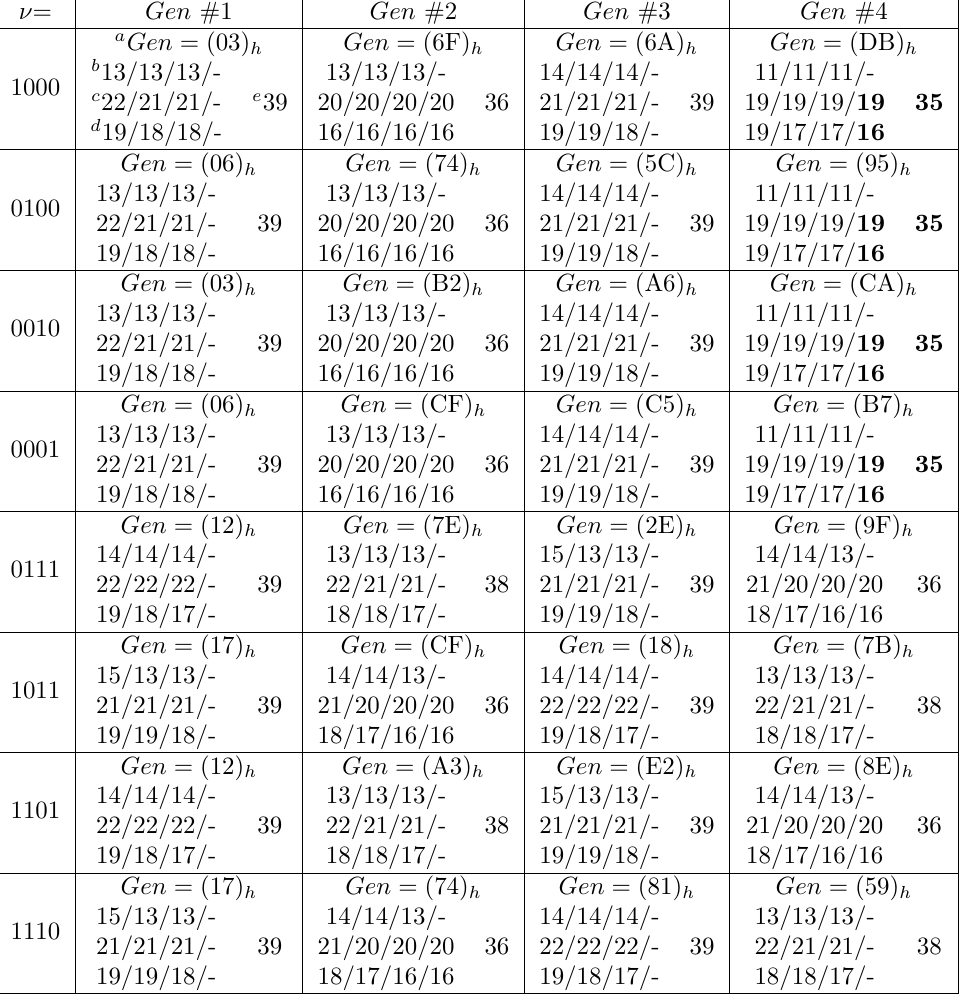
Table 1: Logic minimization of the input matrix X − 1 , the extended-input matrix T in and the extended-output T out transformation